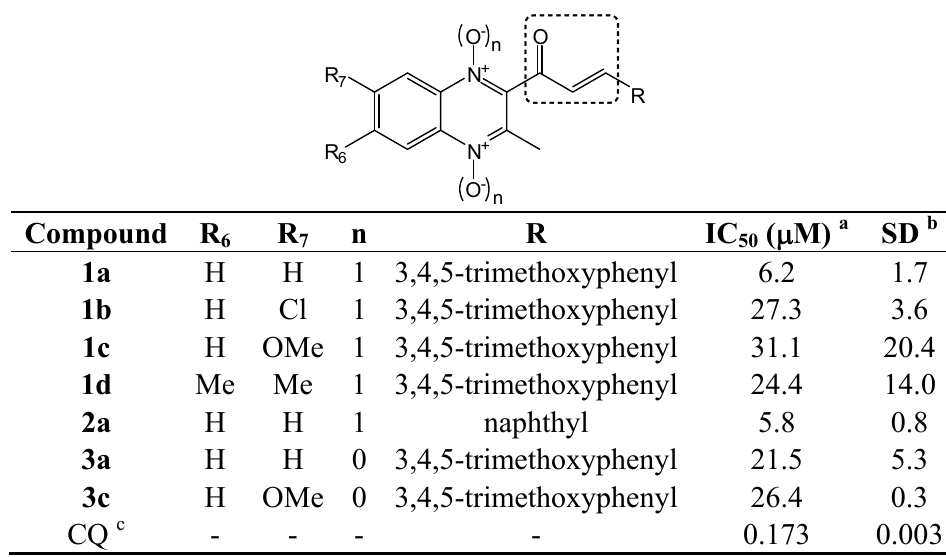
Table 1. In vitro activities of chalcone derivatives.